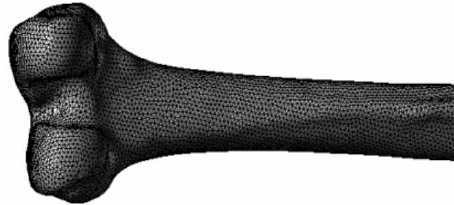
Figure 6. Triangle surface grid of femur bone.